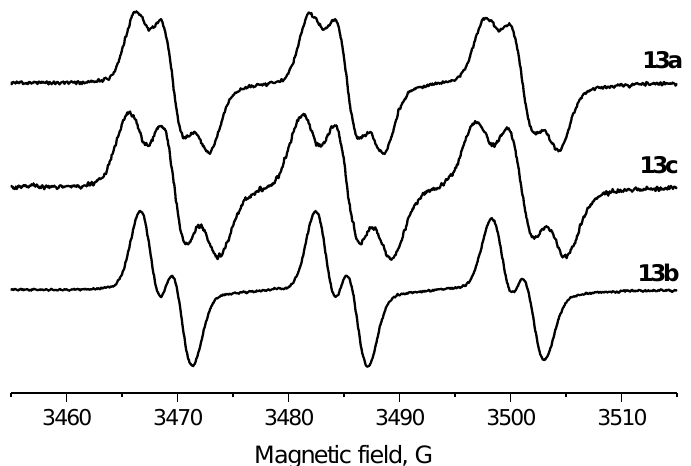
Figure 2. EPR spectra of nitroxides 13a ( top ), 13c ( middle ) and 13b ( bottom ; for conditions, see the Section 3).